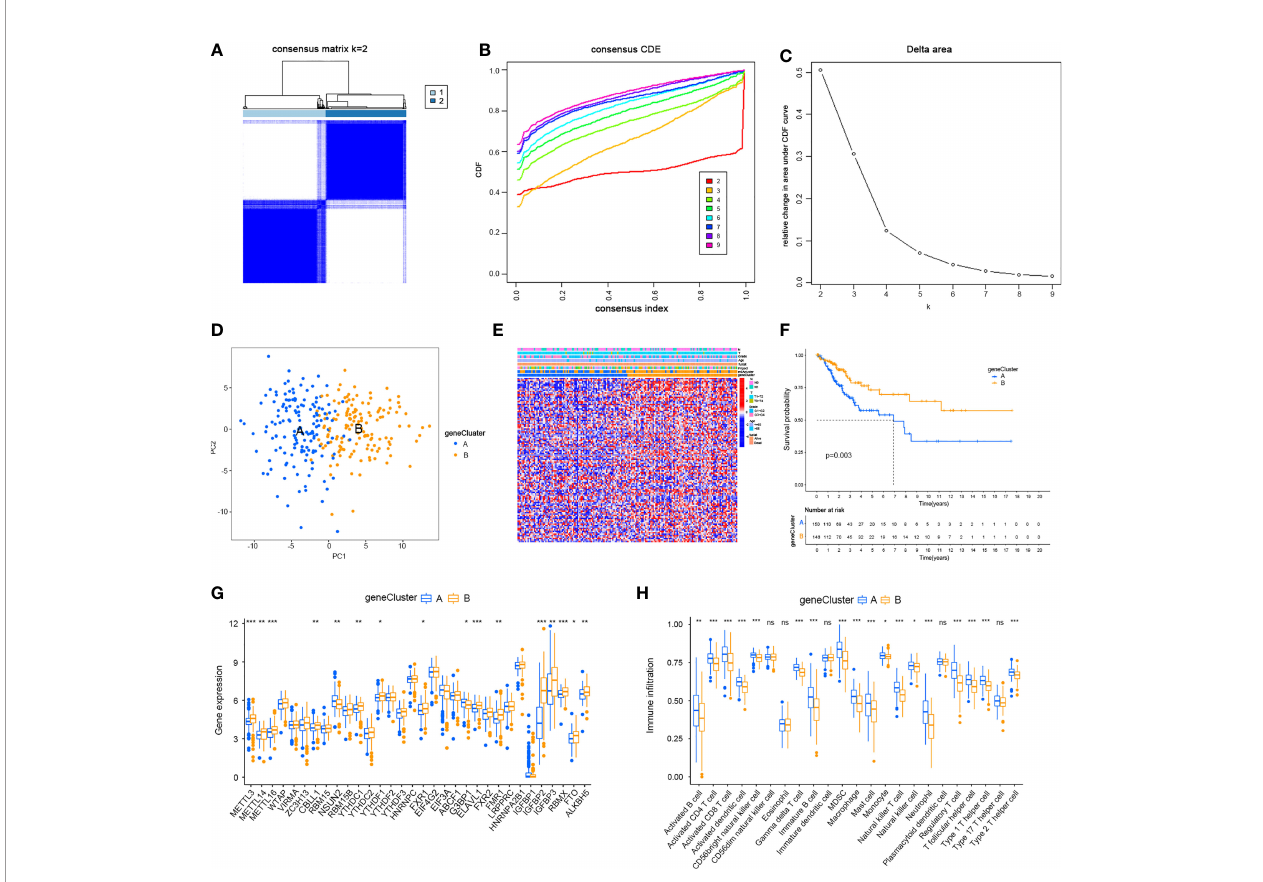
FIGURE 5 | Two genomic subtypes of 114 differentially expressed genes which can affect a cancer patient ’ s prognosis by Unsupervised cluster analysis. (A) Consensus matrix. (B) CDF graph. (C) Relative change in the area under the CDF curve when k= 2 – 9. (D) Two gene clusters by Principal component analysis. (E) Different clinicopathological characteristics of these subgroups shown by Heat maps. (F) Survival analysis of m6A gene clusters by Kaplan – Meier. (G) Expression of m6A regulators in cervical cancer in two gene clusters. (H) Immune in fi ltration in two different m6A gene clusters in cervical cancer (*P < 0.05, **P < 0.01, and ***P < 0.001). ns, not signi fi